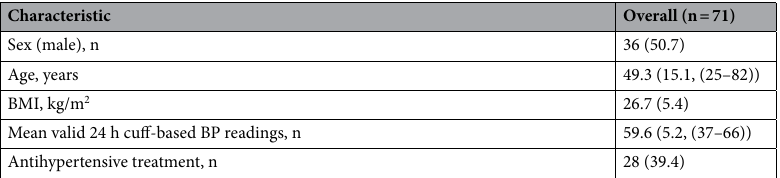
Table 1. Baseline characteristics . Data are mean (± standard deviation, (range)) or counts (percentage), as appropriate. BP blood pressure, BMI Body Mass